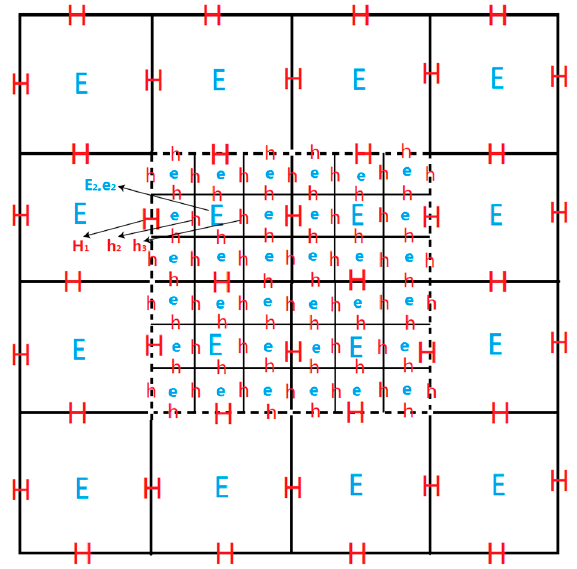
Figure 4. Two-dimensional slicing of main grid and subgrid.